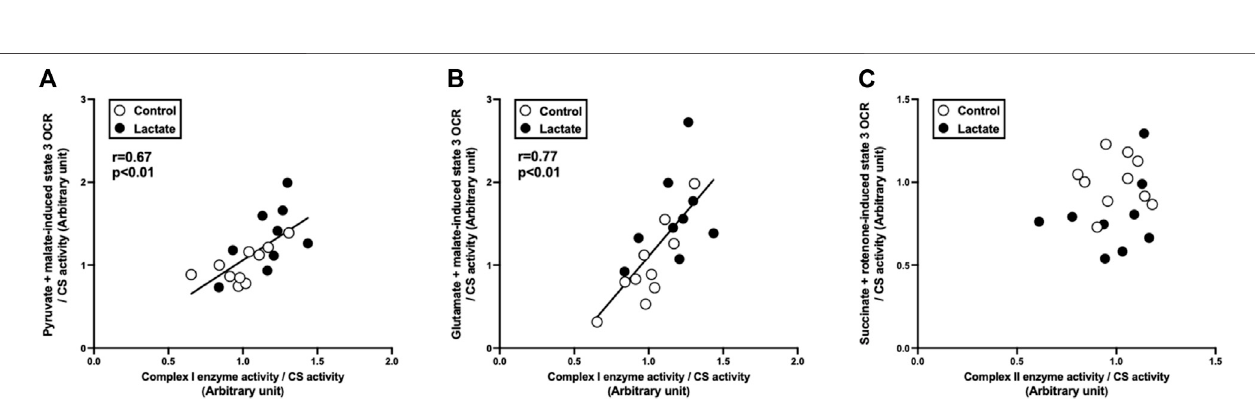
FIGURE 3 | Correlation between state 3 oxygen consumption rate (OCR) and respiratory chain enzyme activity. (A) pyruvate + malate-induced (complex I-driven) state 3 OCR against complex I enzyme activity. (B) glutamate + malate-induced (complex I-driven) state 3 OCR against complex I enzyme activity. (C) succinate + rotenone-induced(complexII-driven)state3OCRagainstcomplexIIenzymeactivity.Dataareexpressedasmean±SD.Controlgroup: n =10,Lactategroup: n =9.The correlation was studied using least-squares linear regressions, followed by the Pearson ’ s correlation coef fi cient test.